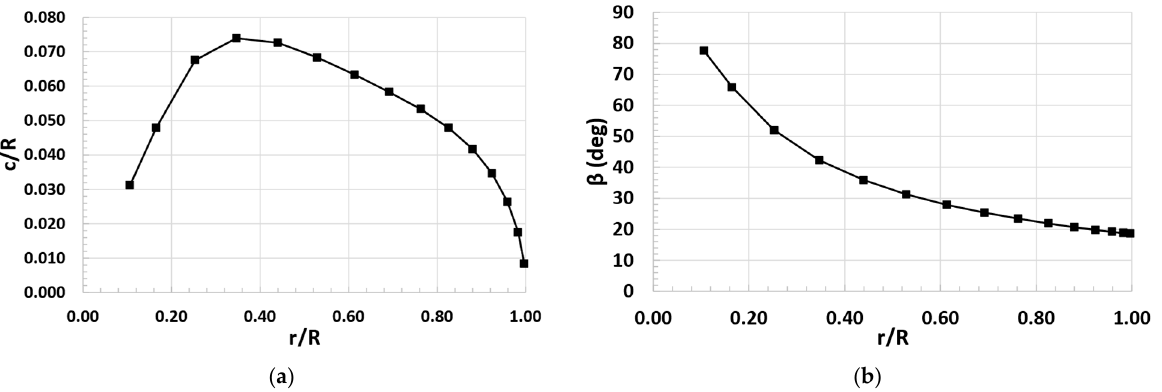
Figure 8. TIP propeller designed with MIL approach. ( a ) Chord distribution. ( b ) Pitch angle distribution. Table 7. Aerodynamic data of M114 and SDA1075 blade airfoil, XFOIL M = 0.15, Re = 3 × 10 6 .